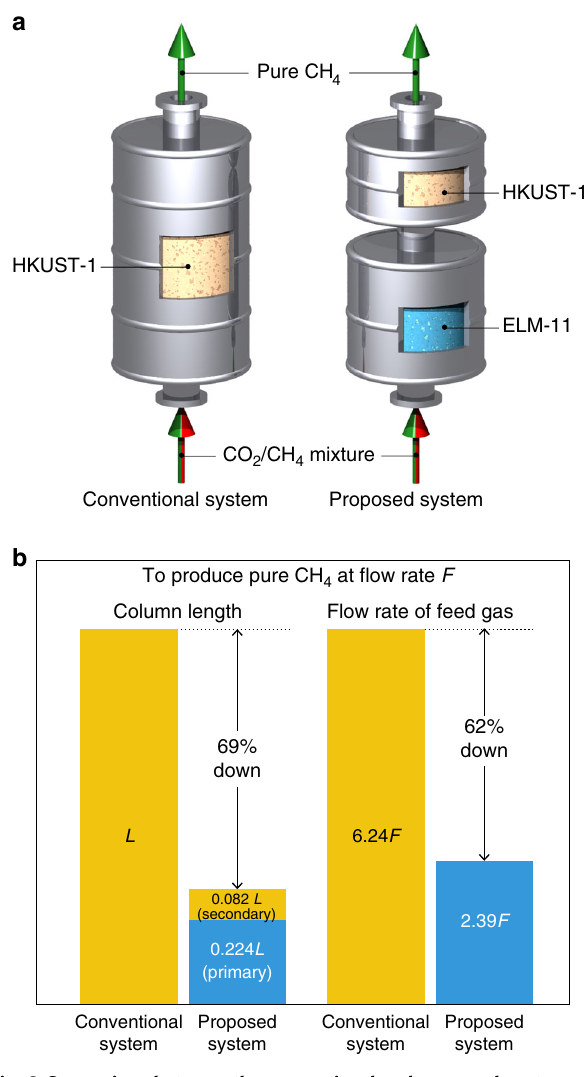
Fig. 8 Comparison between the conventional and proposed systems. a Illustrations of a conventional system using HKUST-1 and our proposed system using ELM-11 and HKUST-1. b Comparison of column length and fl ow rate of feed gas required to obtain the same fl ow rate of product CH F , for the conventional system and our proposed